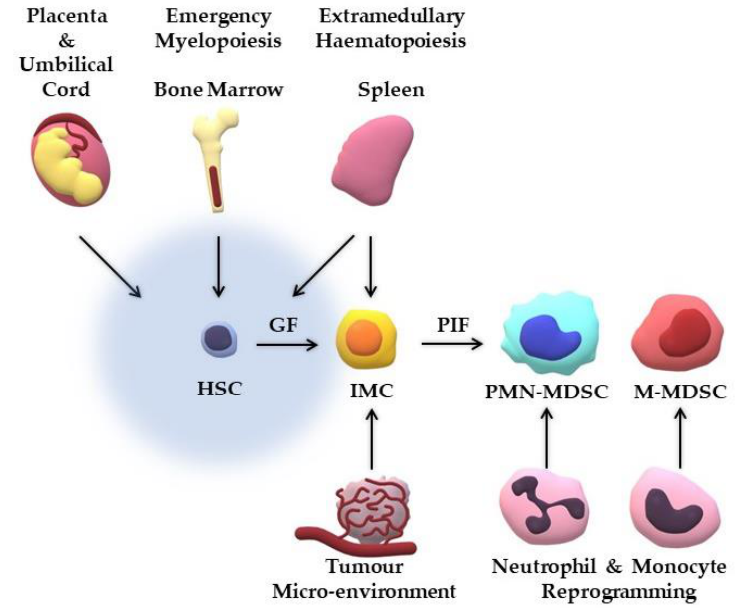
Figure 1. Theories of the origin of MDSCs. The classical theory of the generation of MDSCs is the “two-signal model”. The HSC under the effect of GFs becomes IMC, which under the effect of PIFs turns into an activated with suppressive character cell, i.e., MDSC. Besides the bone marrow, there are also other sites of generation of these cells such as at the site of the tumour, in the spleen, and in the placenta and umbilical cord. Another theory is the reprogramming under specific triggers of mature neutrophils and monocytes to PMN-MDSCs and M-MDSCs, respectively. Abbreviations: HSC — haematopoietic stem cell; IMC — immature myeloid cell; GF — growth factors; PIF — pro-in- flammatory factors; MDSC — myeloid-derived suppressor cell; PMN-MDSC — polymorphonuclear- MDSC; M-MDSC — monocytic-MDSC.